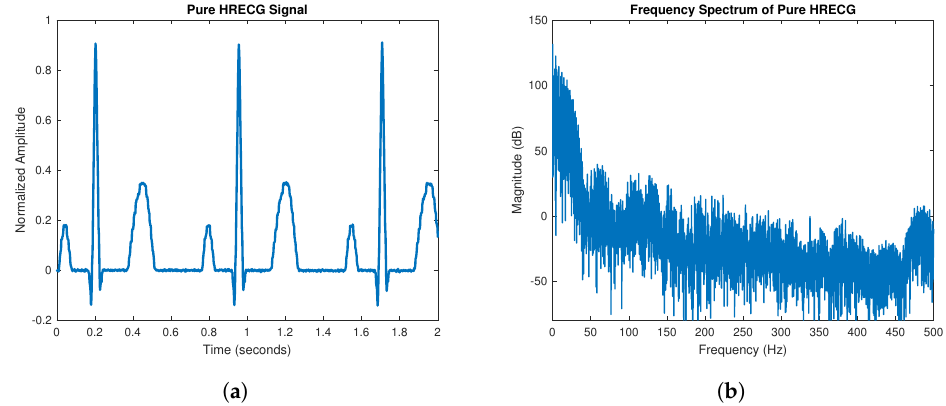
Figure 4. Thenoise-free HRECG cardiac signal, plus its frequency spectrum with a sampling rate of 1000 samples/s. ( a ) Pure HRECG signal; ( b ) frequency response of the HRECG test